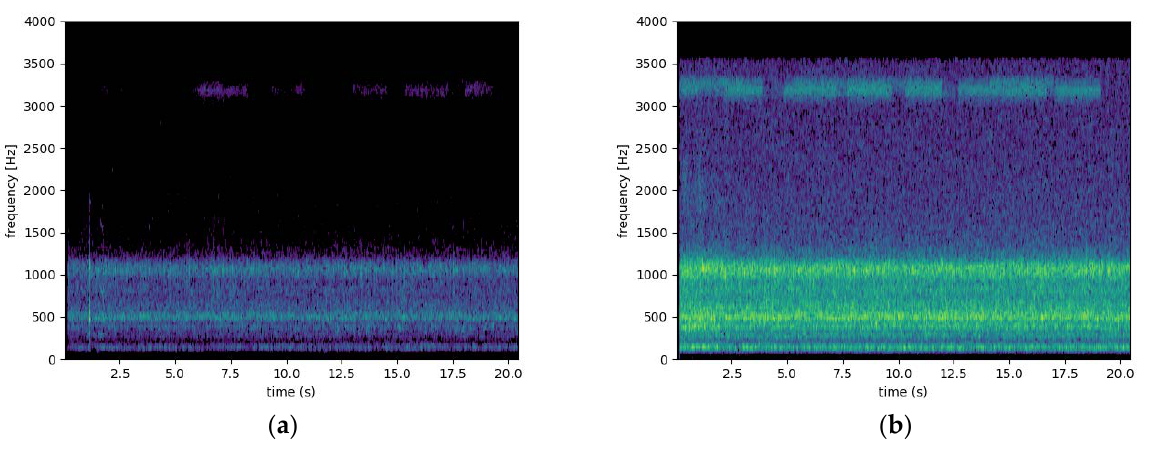
Figure 13. Vibrational signals taken from a piezoelectric transducer from within a hive with several thousand bees. ( a ) a morning recording. ( b ) an evening recording.